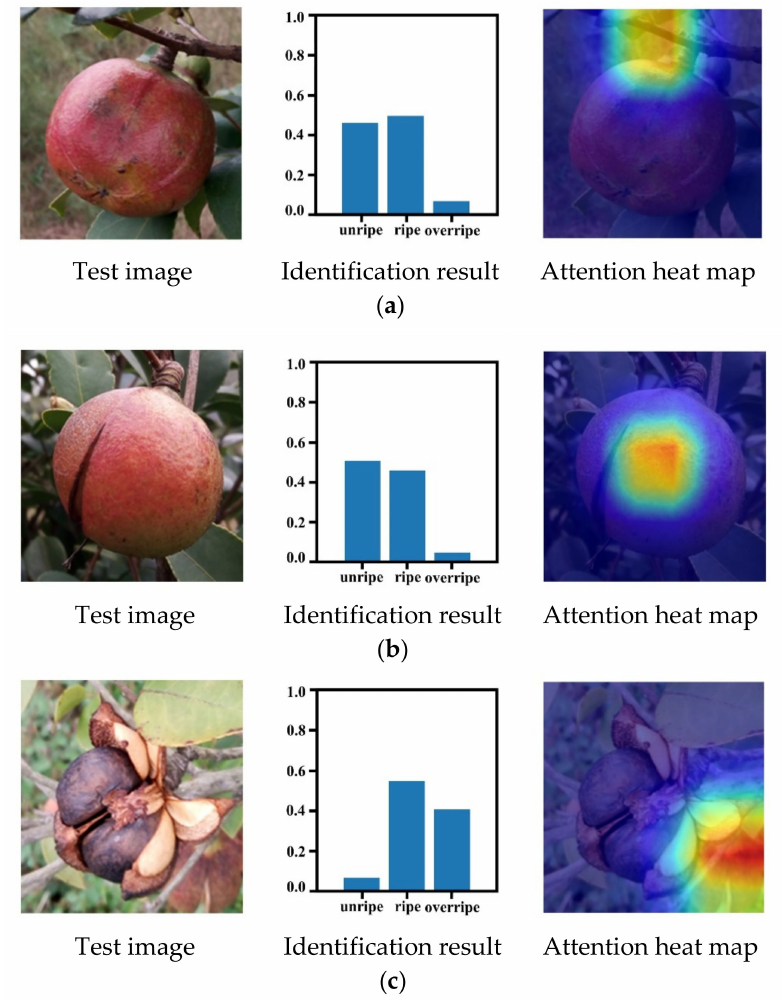
Figure 9. Some example heat maps which identified the maturity stages of Camellia oleifera by the proposed model incorrectly: ( a ) unripe identified as ripe, ( b ) ripe identified as unripe, and ( c ) overripe identified as